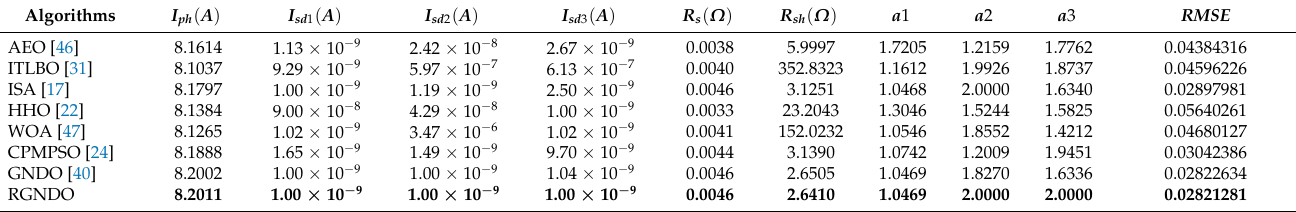
Table 7. Comparison of the best RMSE and its extracted parameter per cell on Kyocera KC200GT.